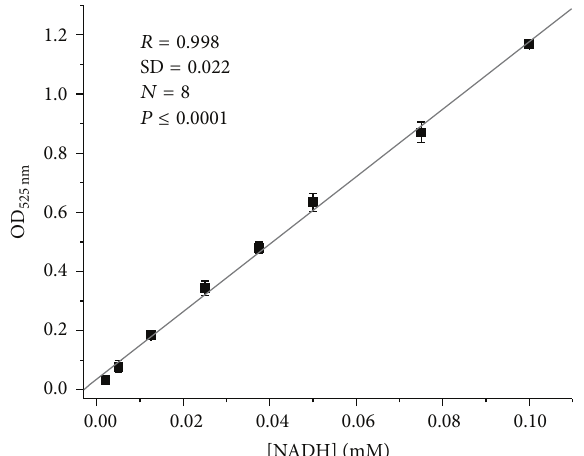
Figure 3: Dependence of optical density of reaction mixture on NADH